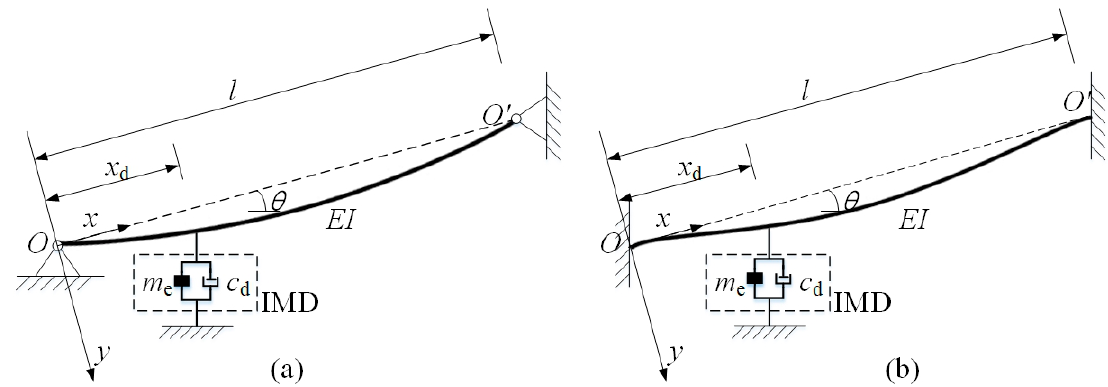
Figure 1. Analysis model of an inclined cable with an inertial mass damper (IMD) ( a ) pinned-pinned 101 ends ( b ) fixed-fixed